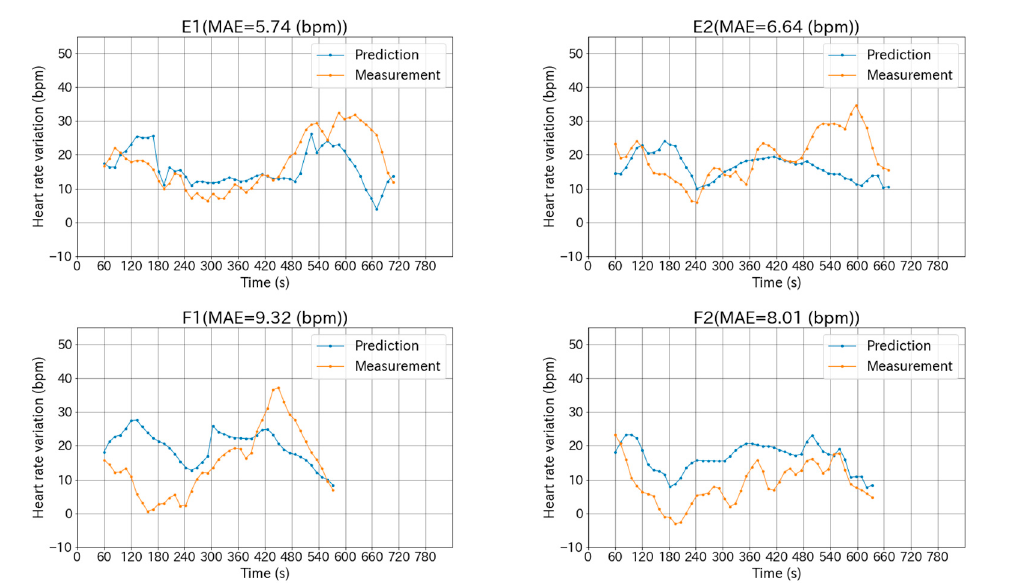
Figure 6. Prediction and measurement of heart rate